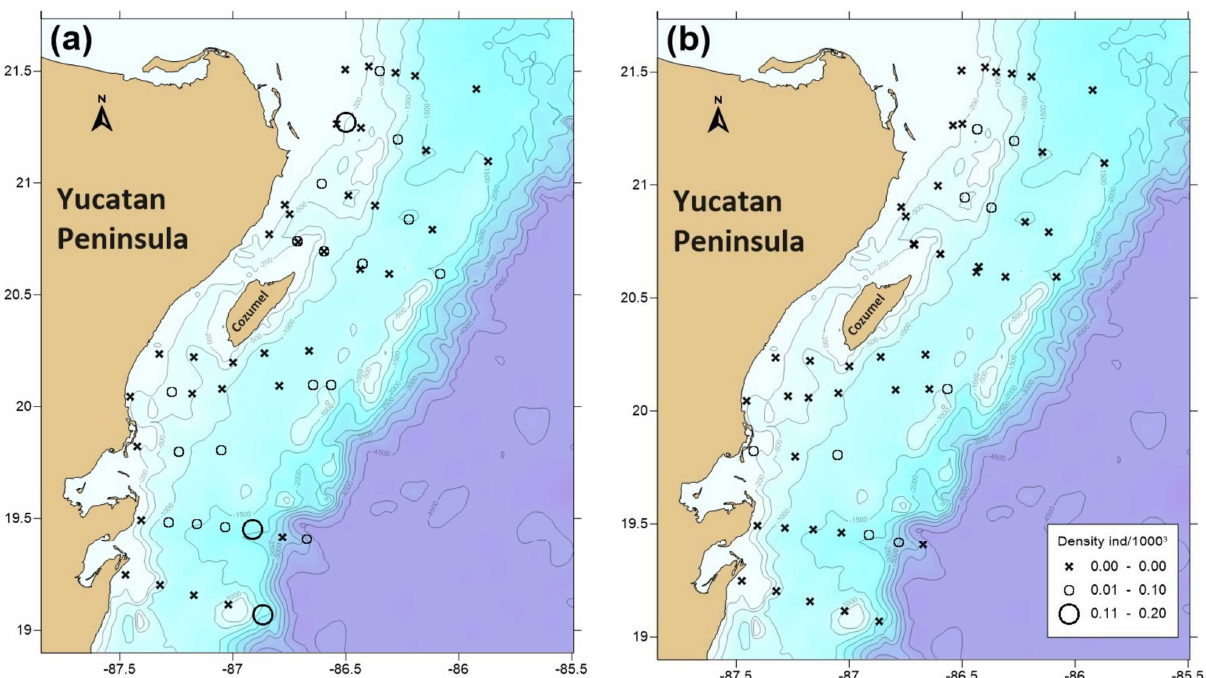
Figure 9. Density (number of larvae per 1000 m 3 of water) of ( a ) mid-stage phyllosomata and ( b ) late-stage phyllosomata of Justitia longimana by sampling station during the autumn 2012 cruise. The scale is the same for both panels.